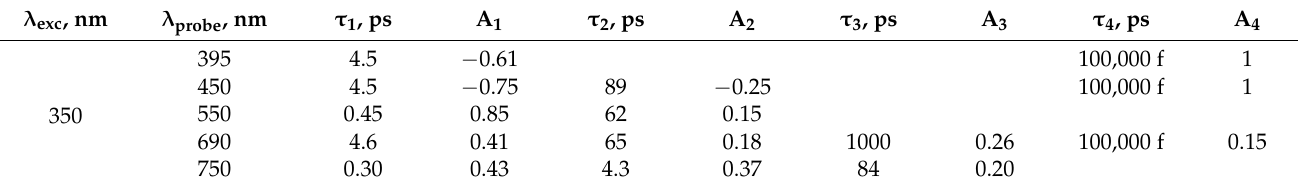
Table 1. Lifetimes obtained from Fit/Deconvolution of TA dynamics for the hexaphenyl film at λ exc = 350 nm; f =